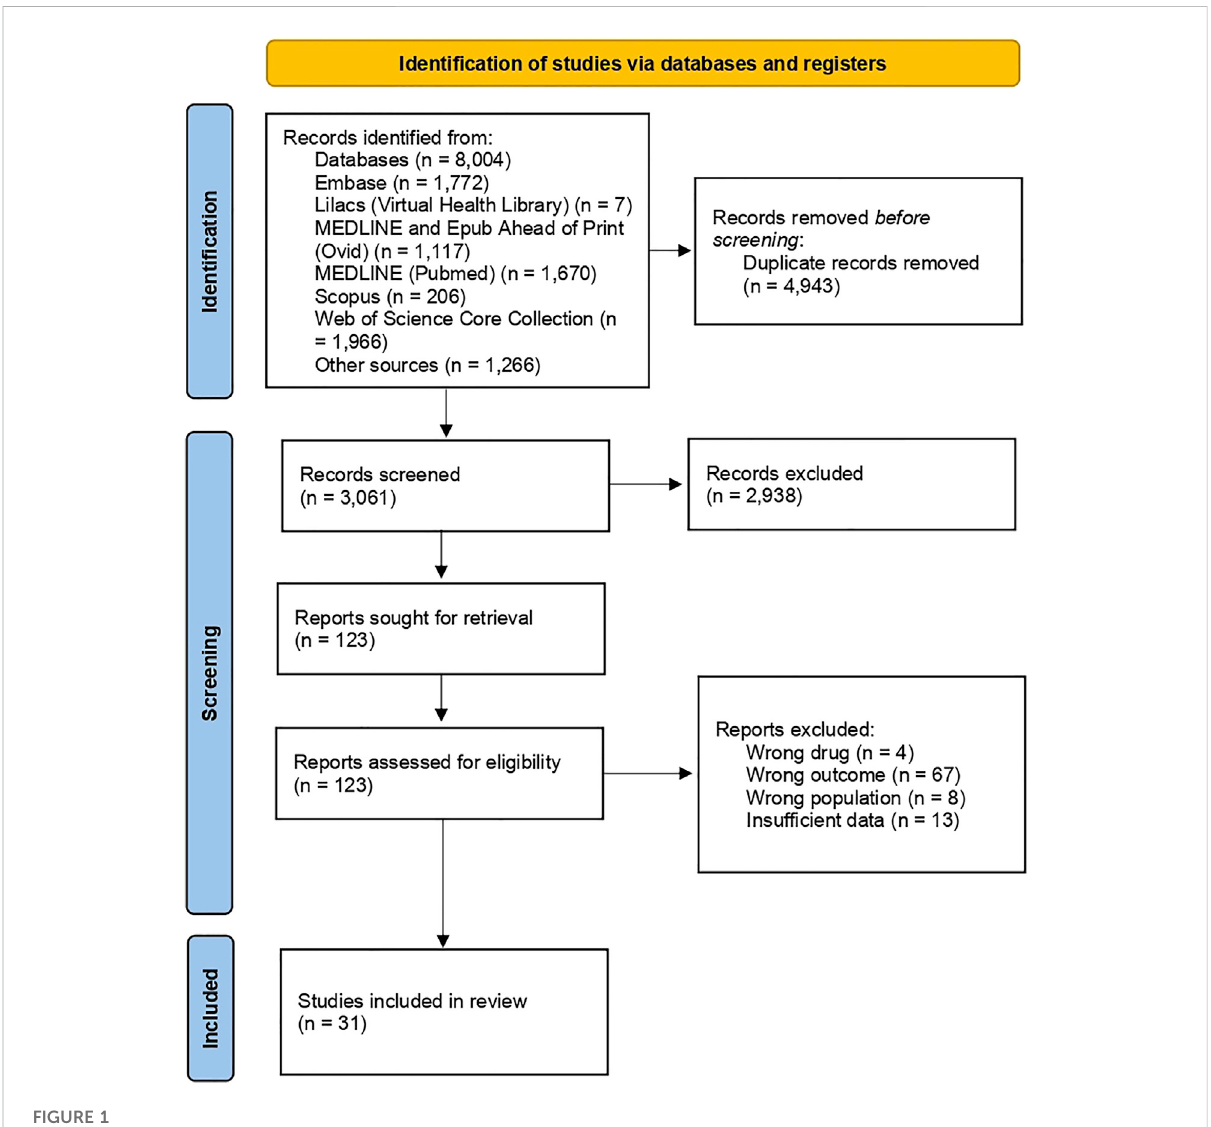
FIGURE 1 Flow chart of search